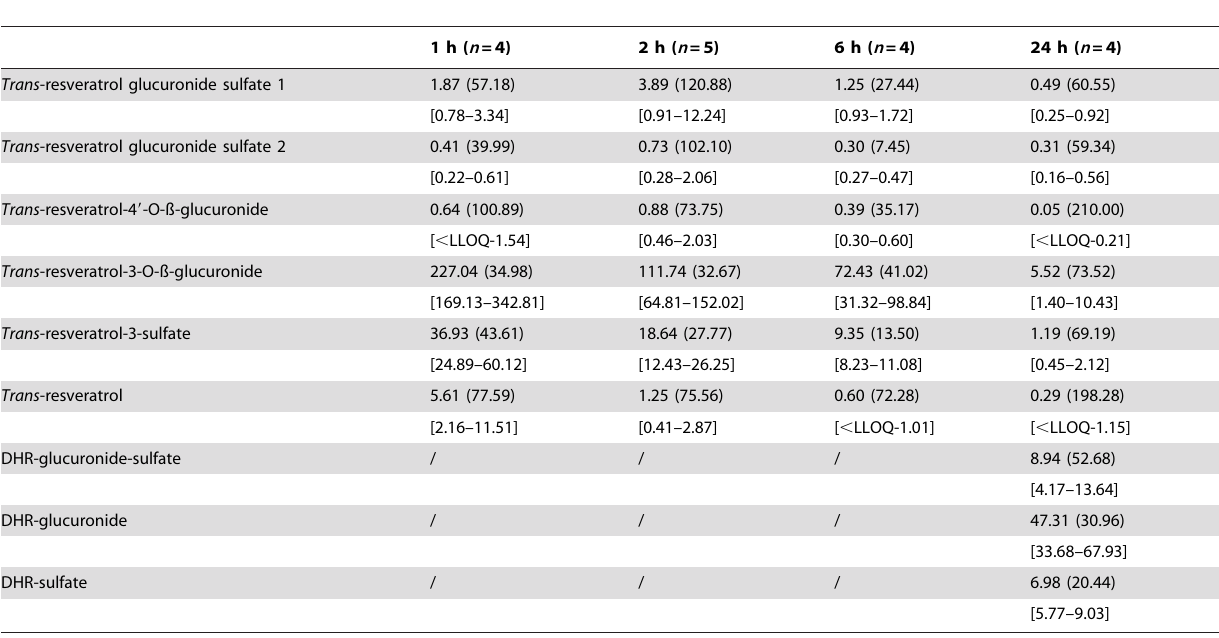
Table 2. Concentrations of trans -resveratrol and its hydrophilic metabolites and hydrophilic metabolites of dihydro-resveratrol (DHR).